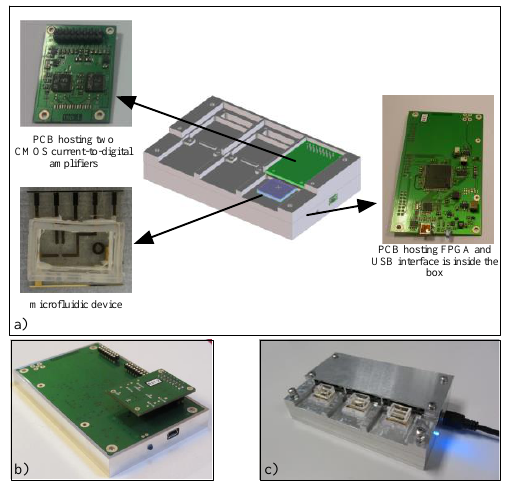
Figure 2. ( a ) Photograph of the 12-channel parallel recording platform highlighting each element: three small PCBs with two CMOS current-to-digital amplifiers described in this paper, three 4-channel microfluidic devices [12], and a PCB with FPGA and USB interface which is housed in the metal box; ( b ) Photograph of the platform showing board connections; ( c ) Photograph of the final platform with the metal box used for shielding.